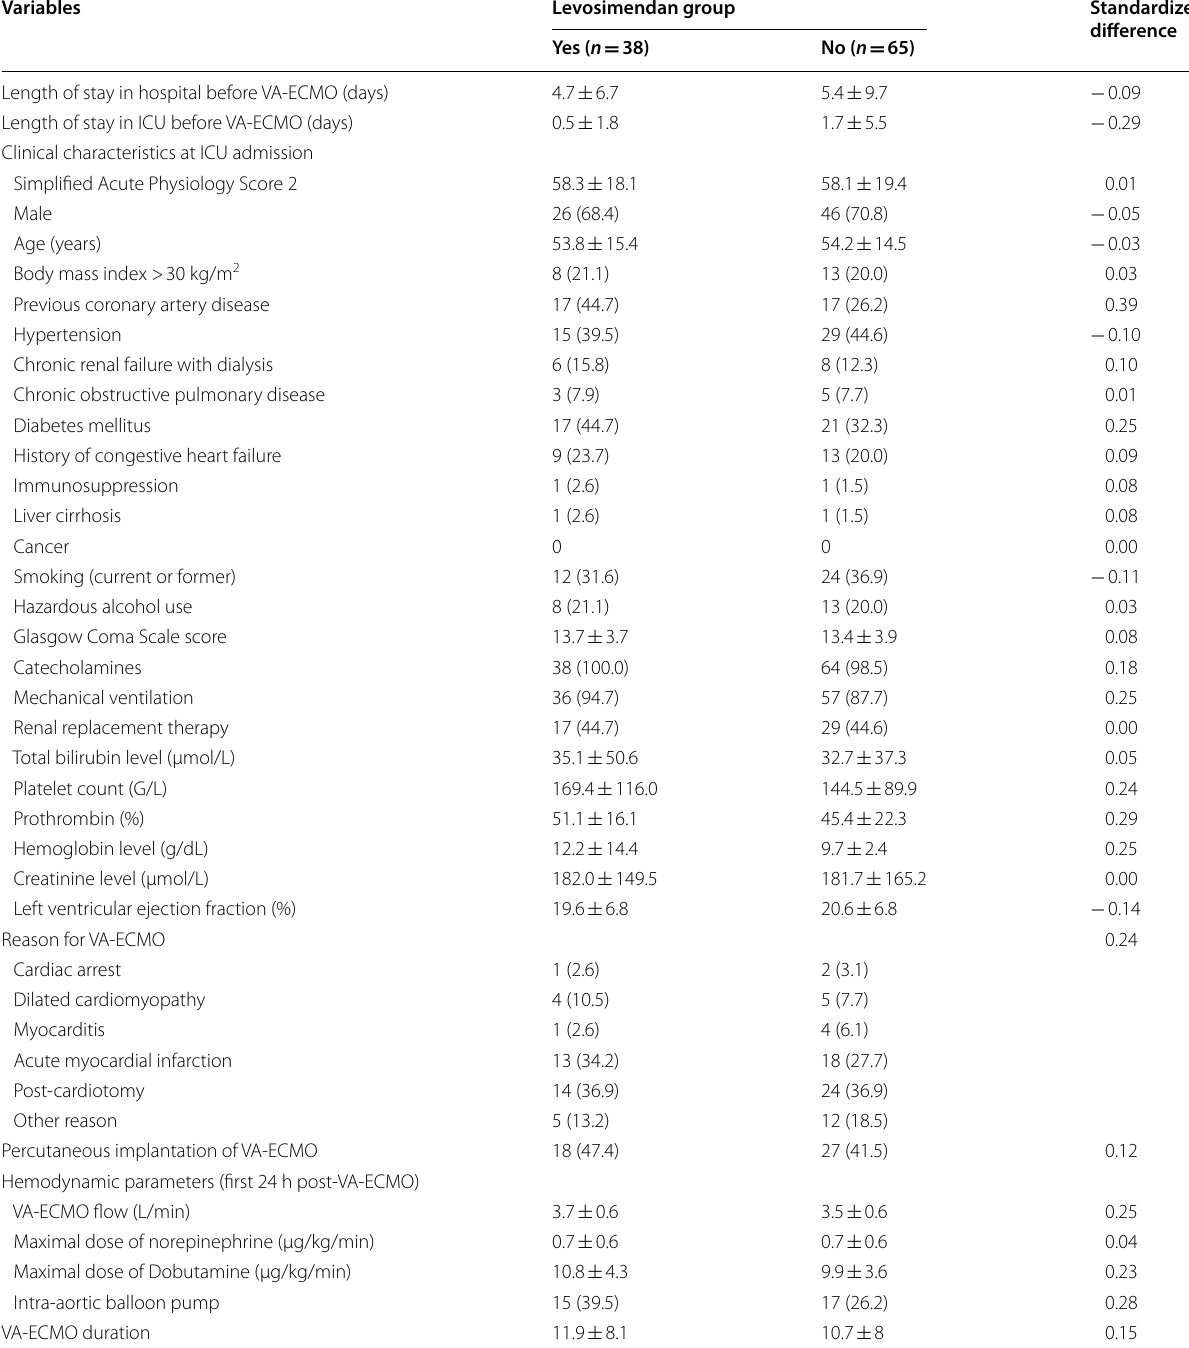
Table 2 Patient characteristics in propensity-matched